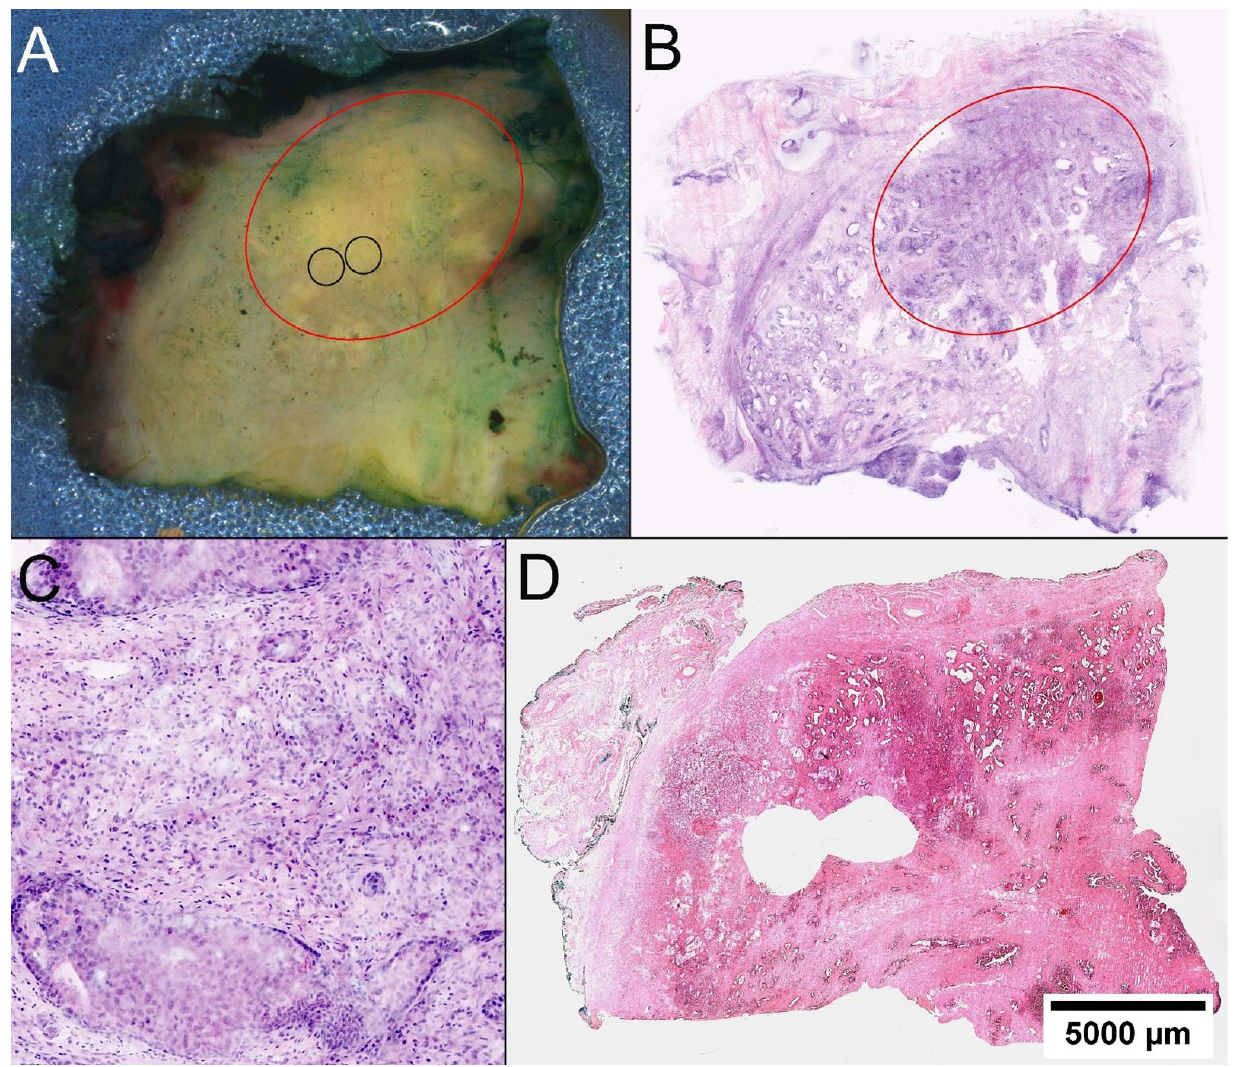
Figure 1. Locating PCa in prostatectomy specimens. ( A ) On the macroscopic image of the quadrate, a discontinuous, yellowish imposing solid foci is distinguishable from the whiter appearing fibrous stroma red circle. Knowing the FCM scan, the tumor was targeted for biopsy (black circles). ( B ) In the FCM scan of the entire quadrant, a well ‐ circumscribed dense tumor tissue demarcates from the surrounding glandular parenchyma. ( C ) At higher magnification, carcinoma infiltrates reveal poorly formed glands and an intraductal tumor component. ( D ) The histological section of the quadrant confirms the sampling of representative tissue from the tumor.